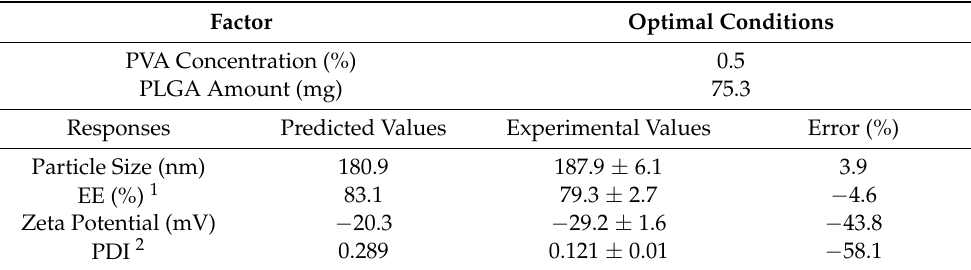
Table 2. Optimal conditions predicted and experimental values of responses.